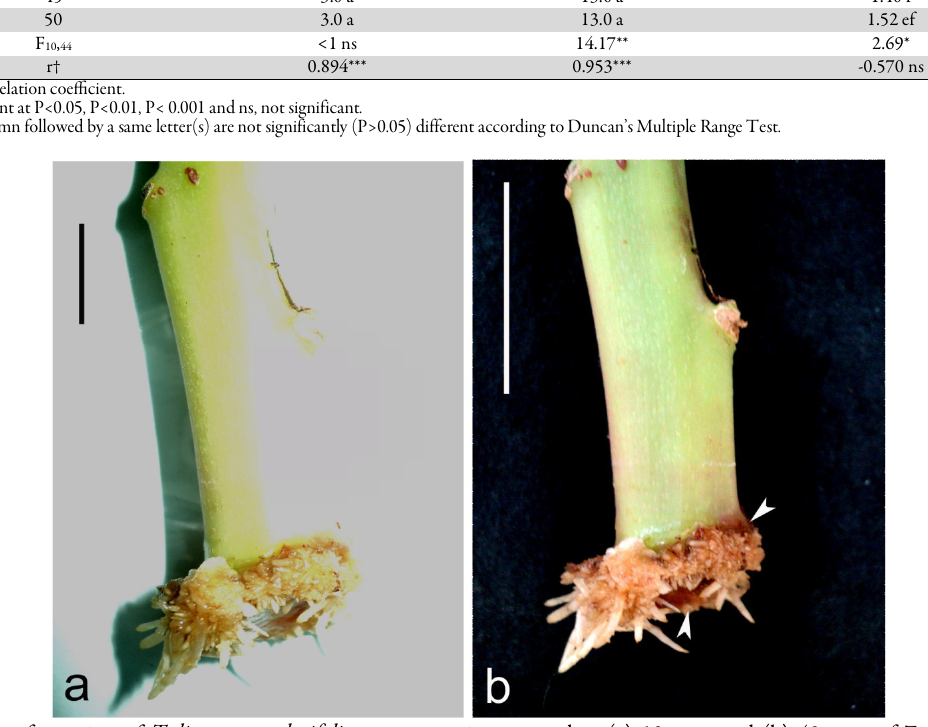
Fig. 1. Callus formation of Talinum portulacifolium stem cutting exposed to (a) 10 ppm and (b) 40 ppm of Zinc. Note the browning and initiation of decay at the cut surface (white arrow heads) in image b. Scale bars =1